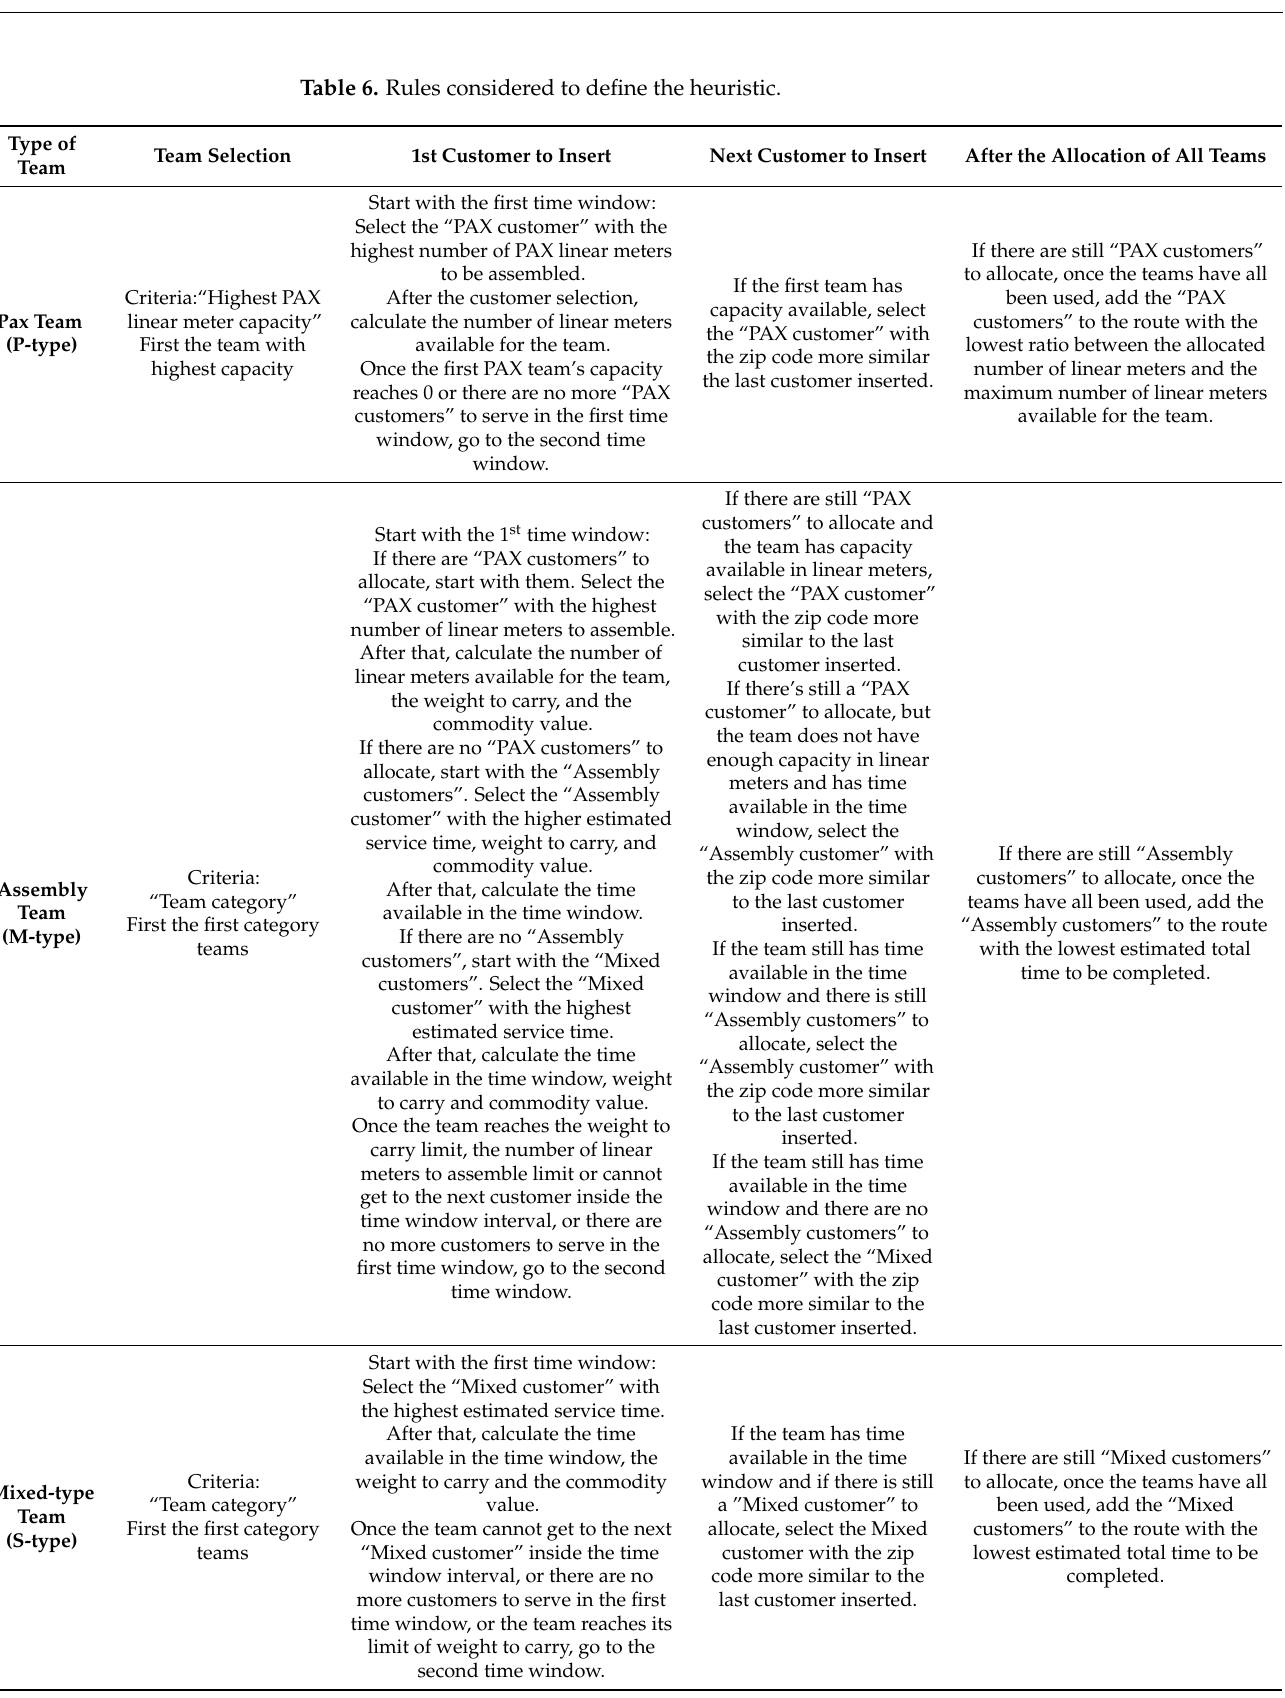
Table 6. Rules considered to define the